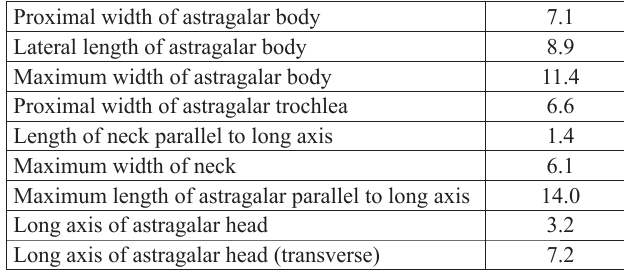
Table 1. Measurements (in mm) for the EOU-UCF-1 astragalus of Hilalia saribeya from the middle Eocene Uzunçar ş ı dere Formation, Central